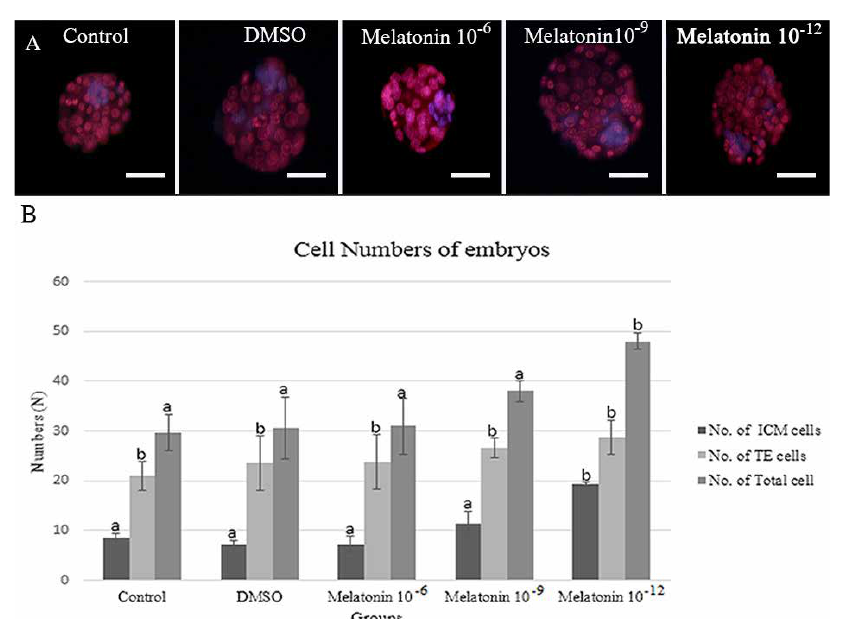
FIGURE 2 – The fluorescence micrograph of differentially labeled mouse blastocysts and chart of the cell number of embryos: (A); the fluorescence micrograph of a differentially labeled mouse blastocyst showing trophectoderm nuclei stains red with propidium iodide and inner cell mass nuclei stains blue with Hoechst H33342 in different doses of melatonin (10 -6 , 10 -9 , 10 -12 M), scale bar 50 µ (B); the chart of cell number, ICM and TE in different groups. Total cells of blastocyst in experimental groups were compared by using the Turkey’s HSD post-hoc test. a,b.c Columns with different lowercase letters differ significantly (P<0.05). Data were presented as mean ± SEM.